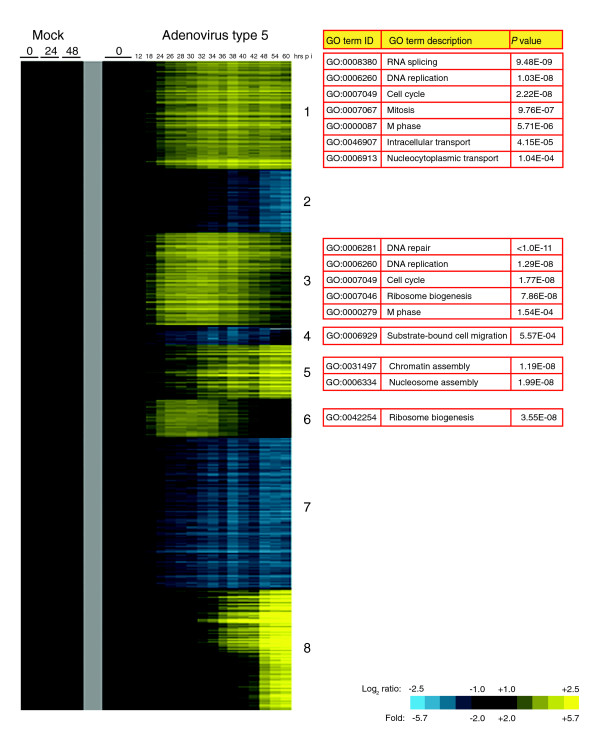
Kinetic patterns of expression of Ad5-responsive genes and associated cellular functions. The log2 expression values of the 2,106 genes that passed the filters described in the text clustered into eight groups are shown at the left, and over-represented Gene Ontology (GO) terms in each cluster at the right. Also shown is a color-bar relating both log2 ratios and fold changes (relative to the average zero values) to color intensity. Ad5, adenovirus type 5.